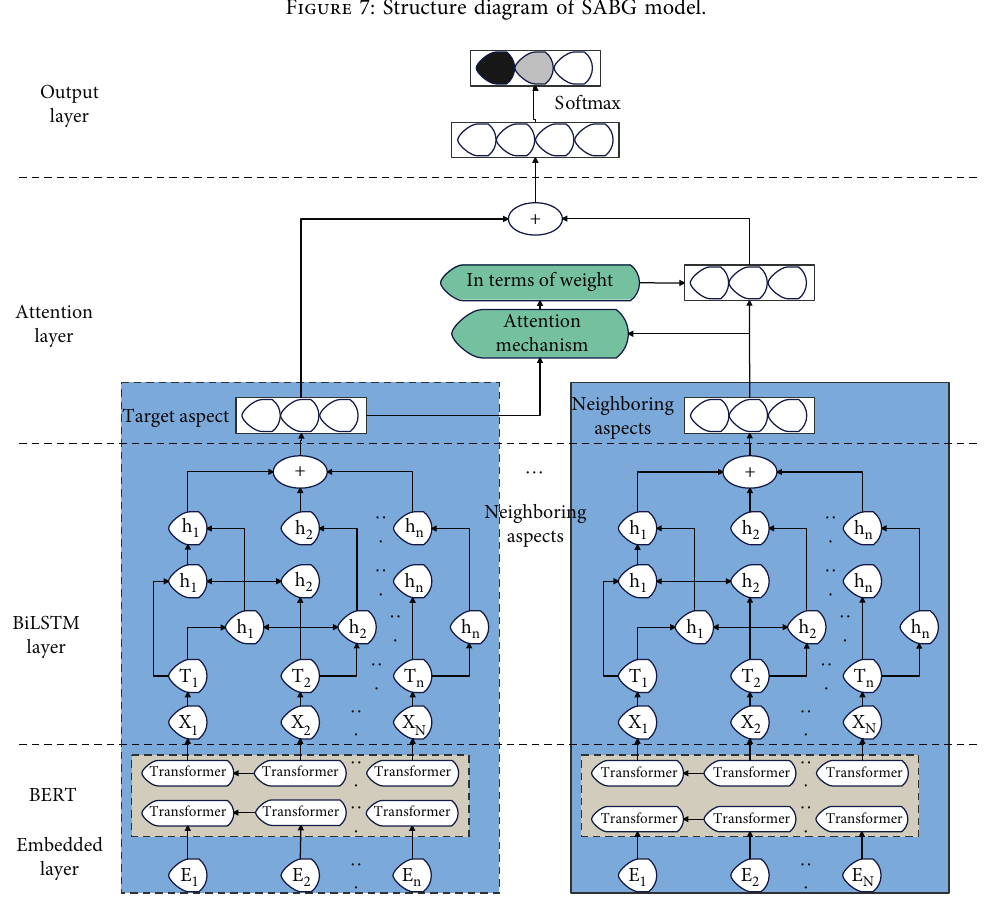
Figure 8: Structural diagram of the emotion analysis model.